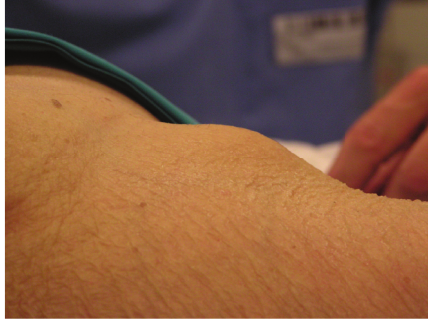
Figure 2: The photograph shows the visible right groin prominence that appeared at about 3 weeks postoperatively.